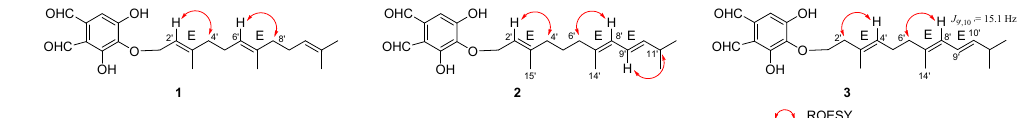
Figure 3. Key NOSEY correlations for compounds 1 – 3 . Compound 2 had a molecular formula of C 23 H 30 O 5 , as inferred by its HR-ESI-MS ( m / z 387.2163, (M + H) + ) (Figure S8), sharing the same molecular formula with compound 1 . The 1 H- and 13 C-NMR spectra (Tables 1 and 2, Figures S9 and S10) of the phe- nolic part of compound 2 were almost the same as those of 1 . However, in the 1D-NMR and HSQC (see Figure S11) spectra of 2 , the farnesyl side chain included four methyls ( δ C 23.0, 23.0, 16.5, 16.3), four methylenes ( δ C 69.4, 39.9, 39.8, 26.5), five methines ( δ C 140.1, 126.2, 124.8, 120.8, 32.1), and two quaternary carbons ( δ C 143.6, 136.6), in contrast to compound 1 . The 1 H- 1 H COSY cross-peaks (Figures 2 and S12) of H 2 -1 ′ /H-2 ′ , H 2 -4 ′ /H 2 -5 ′ /H 2 -6 ′ , and H-8 ′ /H-9 ′ /H-10 ′ /H-11 ′ /Me-12 ′ (Me-13 ′ ) suggested the presence of three olefinic bonds at C-2 ′ /C-3 ′ , C-7 ′ /C-8 ′ , and C-9 ′ /C-10 ′ , respectively. HMBC couplings (Figures 2 and S13) of H 2 -1 ′ ( δ H 4.80, J = 7.3 Hz) to C-2 ′ ( δ C 120.8, d) and C-3 ′ ( δ C 143.6, s), H-2 ′ ( δ H 5.50, td, J = 7.3, 1.2) to Me-15 ′ ( δ C 16.3, q), H 2 -4 ′ ( δ H 1.97, t, 7.4) to C-2 ′ , C-3 ′ and Me-15 ′ , H 2 -5 ′ ( δ H 1.47, m) to C-4 ′ ( δ C 39.9, t) and C-6 ′ ( δ C 39.8, t), H 2 -6 ′ ( δ H 1.88, t, 7.5) to C-4 ′ and Me-14 ′ ( δ C 16.5, q), H-8 ′ ( δ H 5.71, d, J = 10.8 Hz) to C-6 ′ and Me-14 ′ , H-10 ′ ( δ H 5.53, dd, J = 15.2, 7.1 Hz) to C-8 ′ ( δ C 126.2, d), H 3 -12 ′ /13 ′ ( δ H 0.99, d, J = 6.8 Hz) to C-10 ′ ( δ C 140.1, d) and C-11 ′ ( δ C 32.1, d) established the structure of the farnesyl side chain as shown in Figure 1. Moreover, HMBC correlations of 2-OH ( δ H 12.84, s) to C-1 ( δ C 137.6, s), C-2 ( δ C 159.5, s), and C-3 ( δ C 113.6, s) further confirmed the substitution positions of the phenyl ring. NOEs (see Figures 3 and S14) from H 2 -4 ′ to H-2 ′ , from H-8 ′ to H 2 -6 ′ , and from H-9 ′ ( δ H 6.21, ddd, J = 15.1, 10.8, 1.0 Hz) to H-11 ′ ( δ H 2.33, sext, J = 6.8 Hz) supported